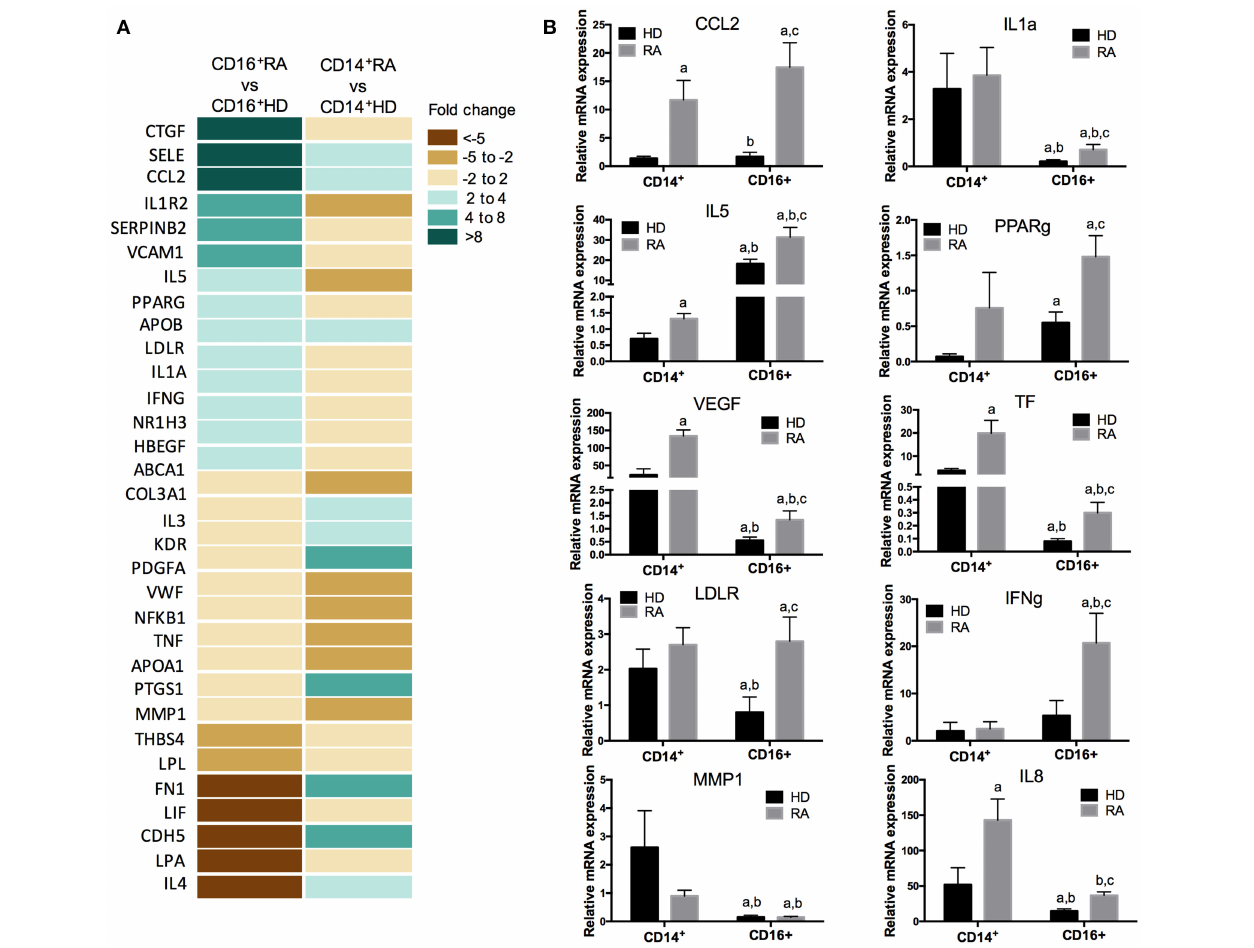
FIGURE 3 | Specific and differential expression profile of genes related to atherosclerosis in CD16 + and CD14 + monocytes from RA patients compared to HDs. (A) Atherosclerosis RT2 profiler PCR array performed in CD14 + and CD16 + monocytes isolated from 12 RA patients and 12 HDs. Heat-map of the differentially expressed genes in CD16 + RA or CD14 + RA monocytes vs. CD16 + HD and CD14 + HD monocytes, respectively. (B) Validation of the PCR array in CD14 + and CD16 + monocytes through RT-PCR in samples of 50 RA patients and 30 HDs, separately. Kruskal-Wallis test, followed by a Dunn’s multiple comparison test was performed. a Indicates significant differences vs. CD14 + HDs, b indicates significant differences vs. CD14 + RA, c indicates significant differences vs. CD16 + HDs ( p <